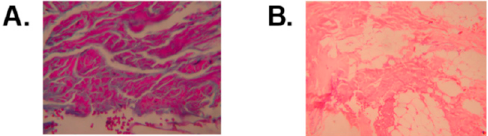
Figure 3. ( A ). Mason’s trichromic stain histopathological view that reveals hypertrophy, atrophy and normal striated muscle fibers that are surrounded by fibrosis and perimysial fat; magnification 10x. ( B ). Hematoxylin–eosin stain that shows striated muscle with intermingled hypertrophic, atrophic, and normal fibers that are surrounded by a proliferation of collagenous fibro connective tissue that is replaced, in other instances, by adipose tissue; magnification 4x.